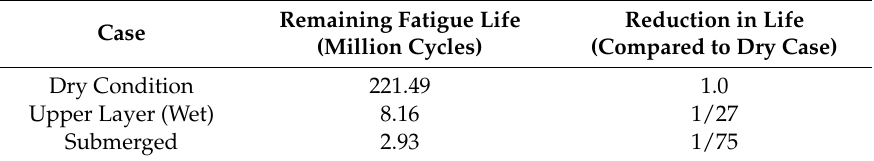
Figure 8. Load cycles and central live load deflection of dry and wet ambient conditions. Table 2. Remaining fatigue life of dry and wet ambient